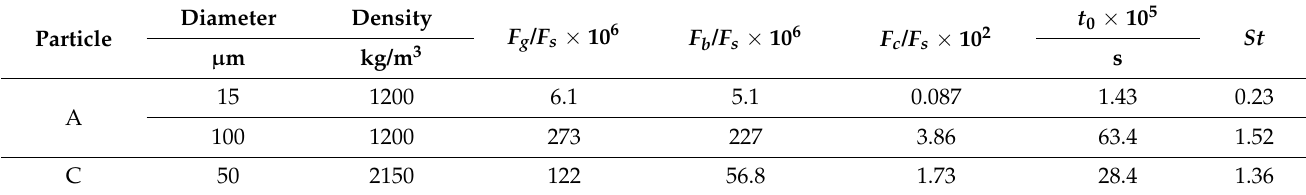
Table 2. Ratios of main forces acting on particles and their Stokes